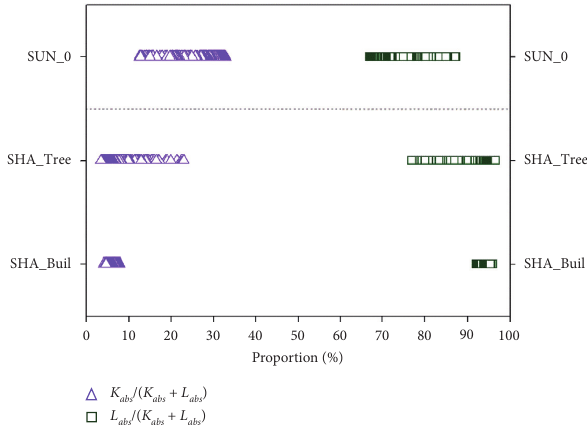
Figure 9: Proportion of K abs and L abs in K abs + L abs at the shaded and sunlit